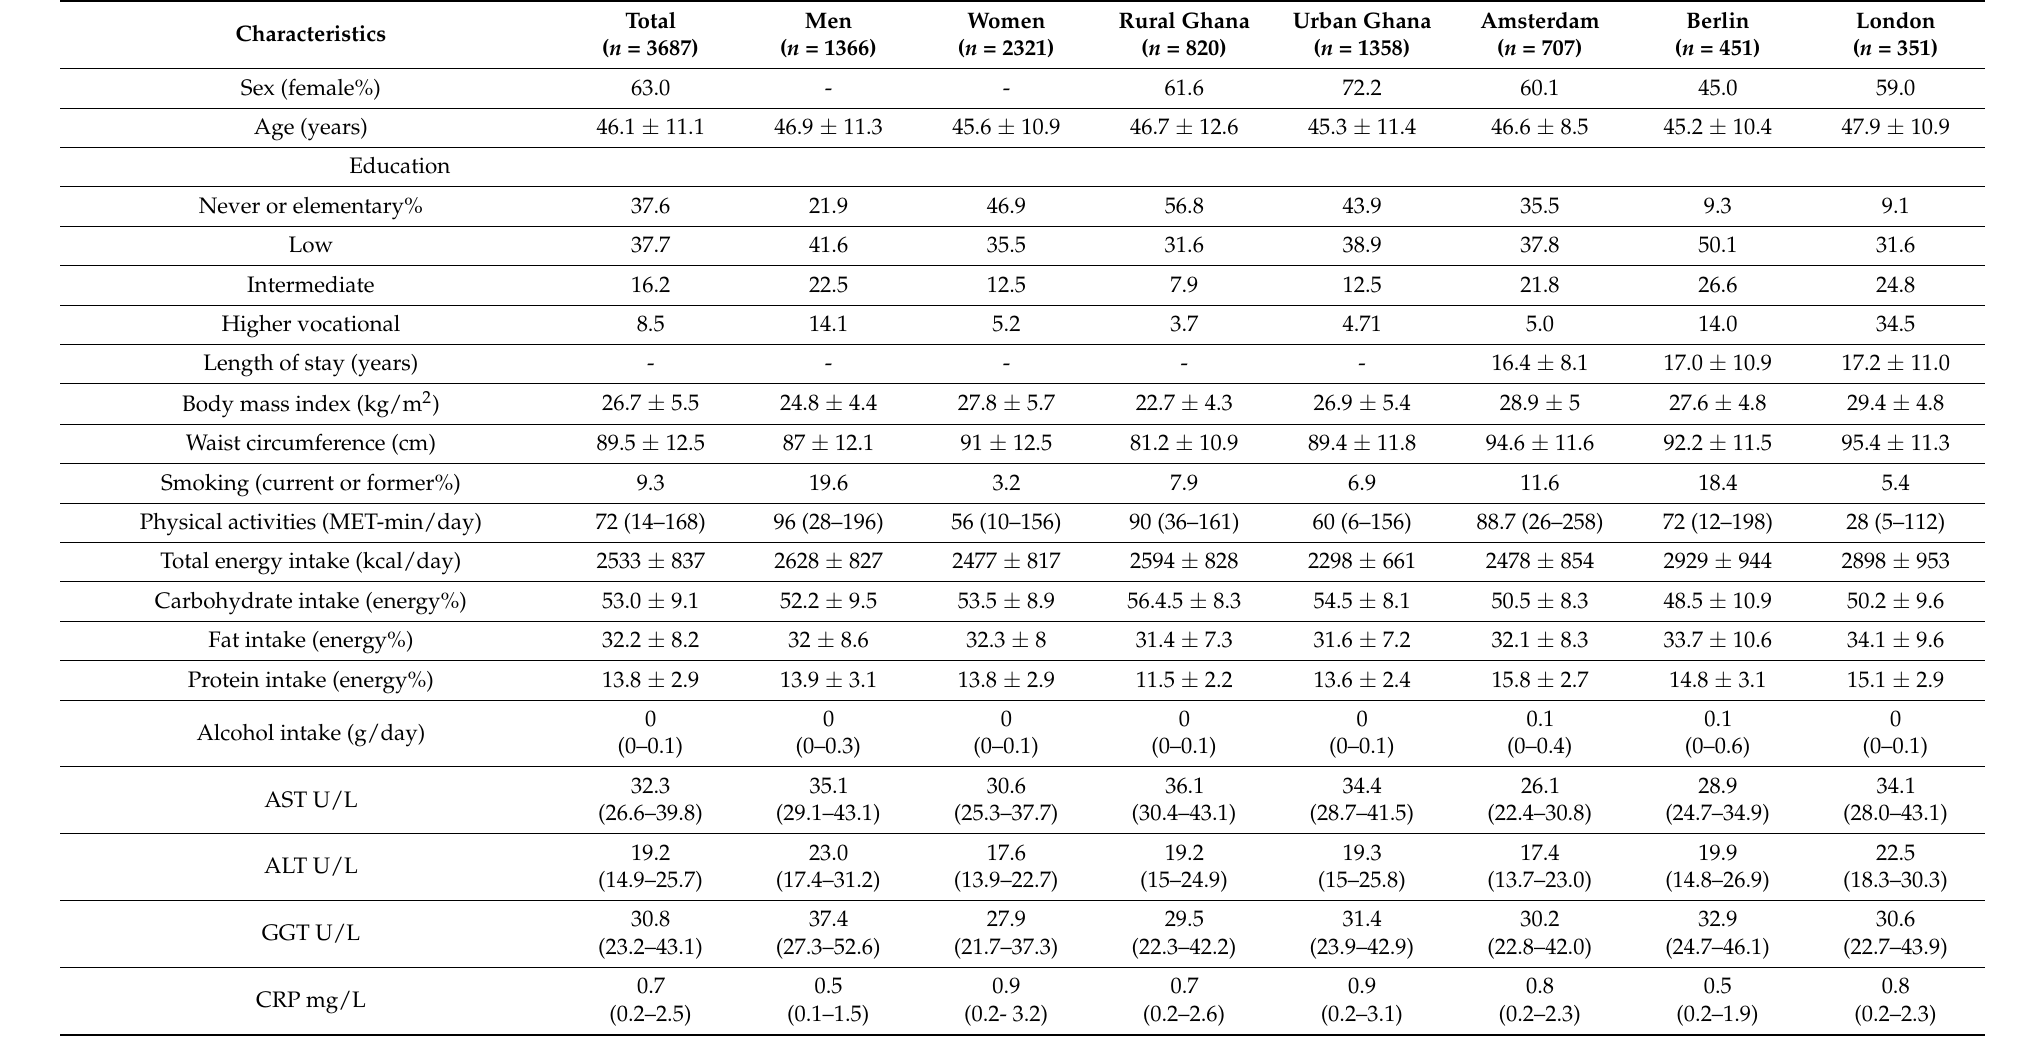
Table 1. Characteristics and biomarkers of the RODAM study population by sex and site 1